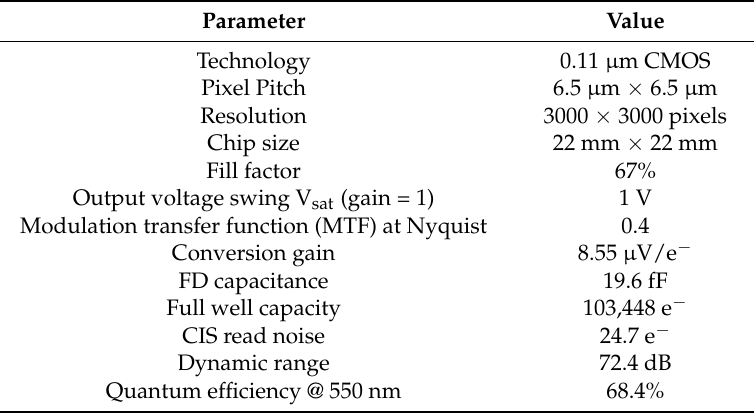
Table 1. Characteristics of the CIS.